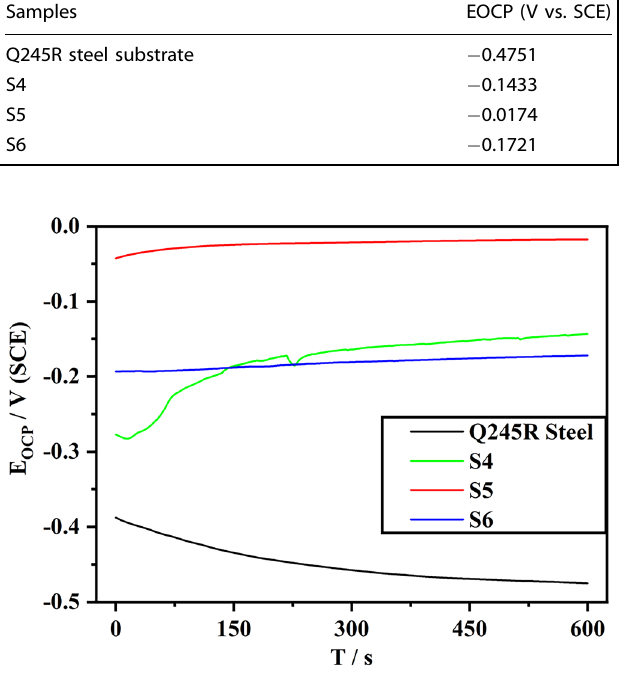
Fig. 7 The open-circult-potential curve of Q245R steel substrate (black) and Inconel 625 coatings on Q245R steel: S4 (green), S5 (red), S6 (blue).